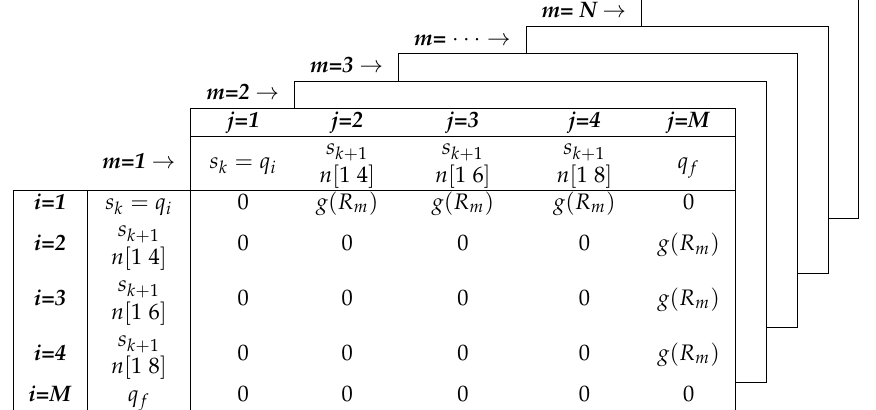
Table 3. Initial multidimensional transition matrix listed by first column ( i = 1 . . . M ) and the first row ( j = 1 . . . M ) . The number of levels are given by the number of N functions R m for the particular navigation